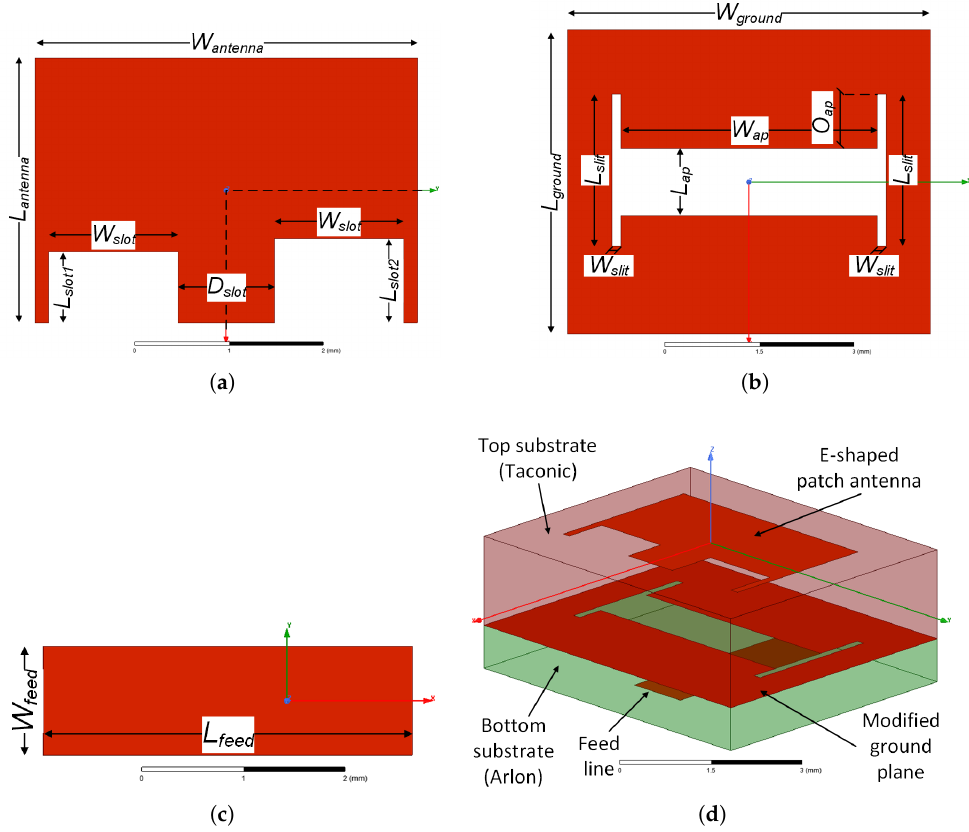
Figure 8. Design of the aperture-coupled E-shaped antenna ( a ) patch antenna, ( b ) modified ground plane, ( c ) feed line, and ( d ) perspective view of the proposed